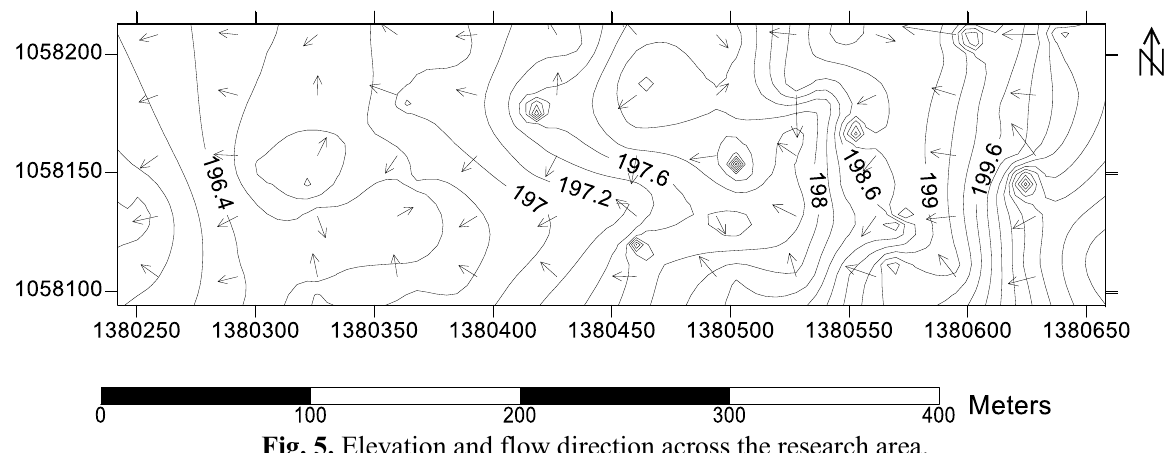
Fig. 5. Elevation and flow direction across the research